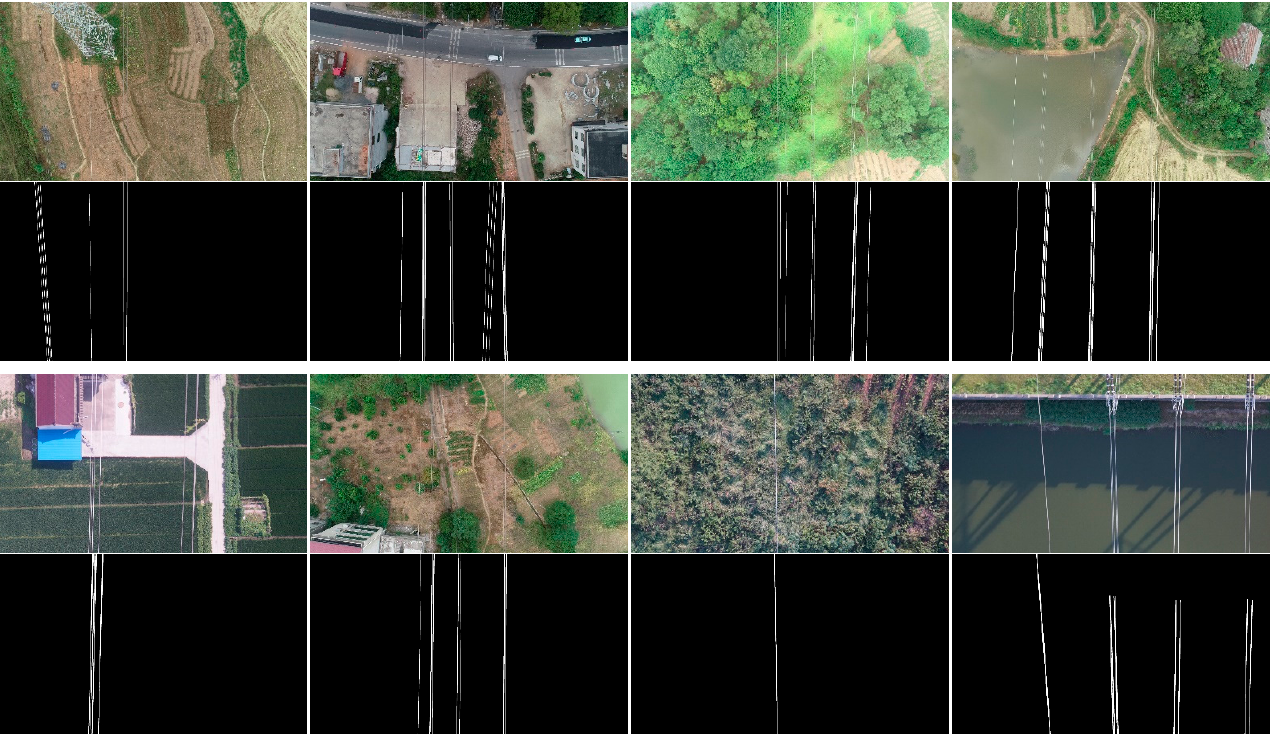
Figure 8. Partial image of the test dataset.